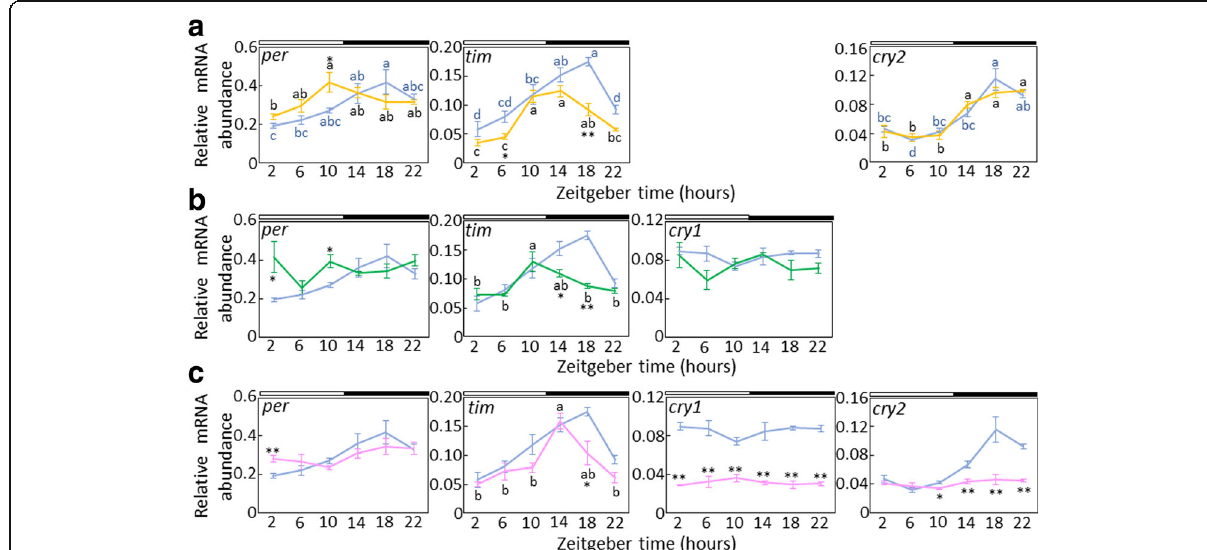
Fig. 5 Effects of Gb ’ cry1 RNAi ( a ), Gb ’ cry2 RNAi ( b ), and Gb ’ cry1 RNAi / Gb ’ cry2 RNAi ( c ) on daily clock gene expression. Relative abundance of Gb ’ per , Gb ’ tim , Gb ’ cry1 , and Gb ’ cry2 mRNA in the optic lobes are shown for intact ( blue ) and Gb ’ cry1 RNAi ( yellow ) ( a ), Gb ’ cry2 RNAi ( green ) ( b ), and Gb ’ cry1 RNAi / Gb ’ cry2 RNAi ( pink ) adult male crickets ( Gryllus bimaculatus ) ( c ). The data for intact Gb ’ cry1 and Gb ’ cry2 mRNA are replotted from Fig. 2. In dsRNA- injected crickets, the optic lobes were collected about seven days after the dsRNA injection. The abundance of mRNA was measured by quantitative real-time RT-PCR with total RNA extracted from the optic lobes. The data collected from 3 and 5 independent experiments were averaged and plotted as mean±SEM for dsRNA-injected and intact crickets, respectively. The abundance of Gb ’ rpl18a mRNA was used as an internal reference. Asterisks indicate significant difference between intact and treated crickets (* P <0.05, ** P <0.01, t- test). Different letters indicate that values are significantly different with each other (ANOVA followed by Tukey-test, P <0.05). For further explanations, see the text